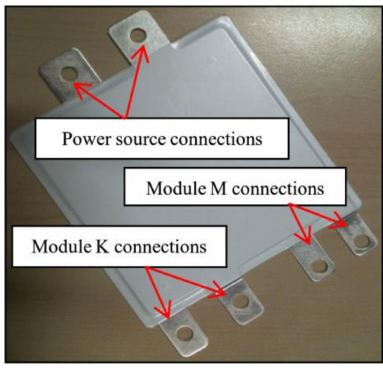
Figure 2. Busbar used for the setups.